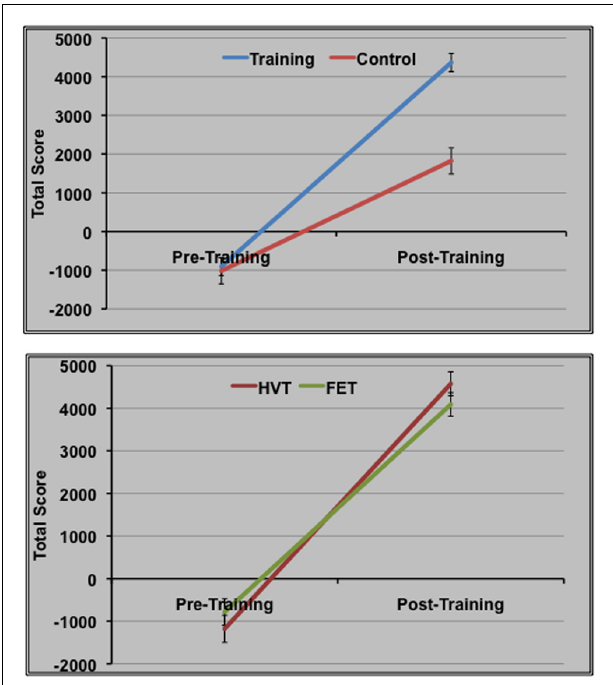
FIGURE 2 | Space Fortress behavioral data for the three groups at pre- and post-training.